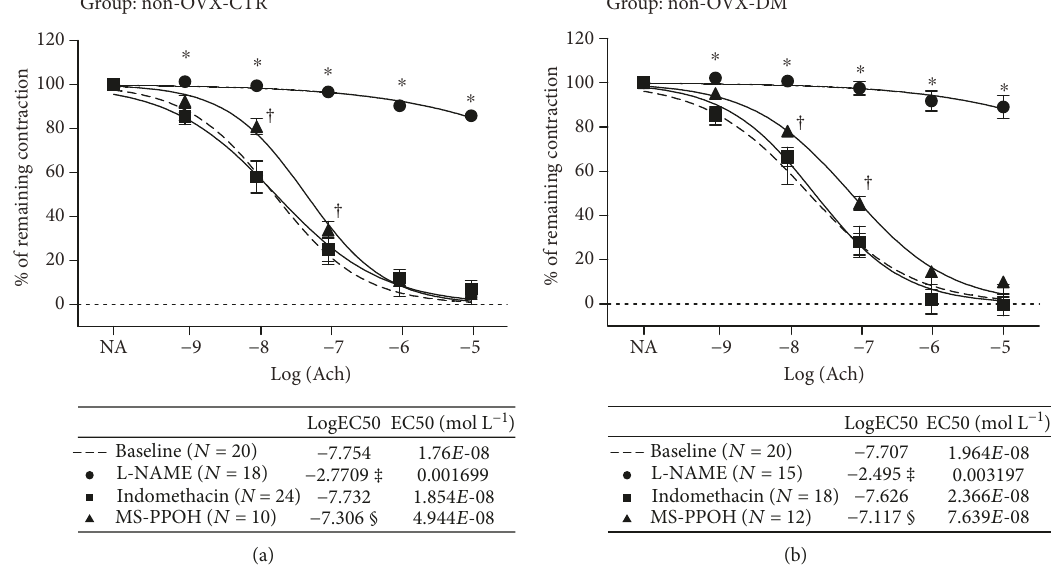
Figure 2: Mechanisms of acetylcholine-induced relaxation (AChIR) response of isolated rat aorta rings in non-OVX-CTR and non-OVX- DM rats. (a) and (b) present the relaxation of isolated aortic rings in response to ACh (presented as log [ACh] of ACh concentration (10 -9 to 10 -5 M)) in the non-OVX-CTR (a) and non-OVX-DM (b) groups of rats. The presence of L-NAME and MS-PPOH signi fi cantly reduced the AChIR of isolated rat aortic rings in the non-OVX-CTR group (a) and non-OVX-DM group (b) of rats. Indomethacin administration did not have any signi fi cant e ff ects on AChIR in both the non-OVX-CTR (a) and non-OVX-DM (b) groups of rats. Data were compared by two-way ANOVA and Bonferroni post hoc tests. Sensitivity to ACh in the presence of L-NAME and MS- PPOH was signi fi cantly decreased compared to the basic response or response to ACh in the presence of Indomethacin in both the non-OVX-CTR and non-OVX-DM groups of rats. LogEC50 values were compared by one-way ANOVA followed by Holm-Sidak pairwise multiple comparison. Statistically signi fi cant ( P < 0 05 ) AChIR in the presence of L-NAME ( ∗ ) or MS-PPOH ( † ) compared